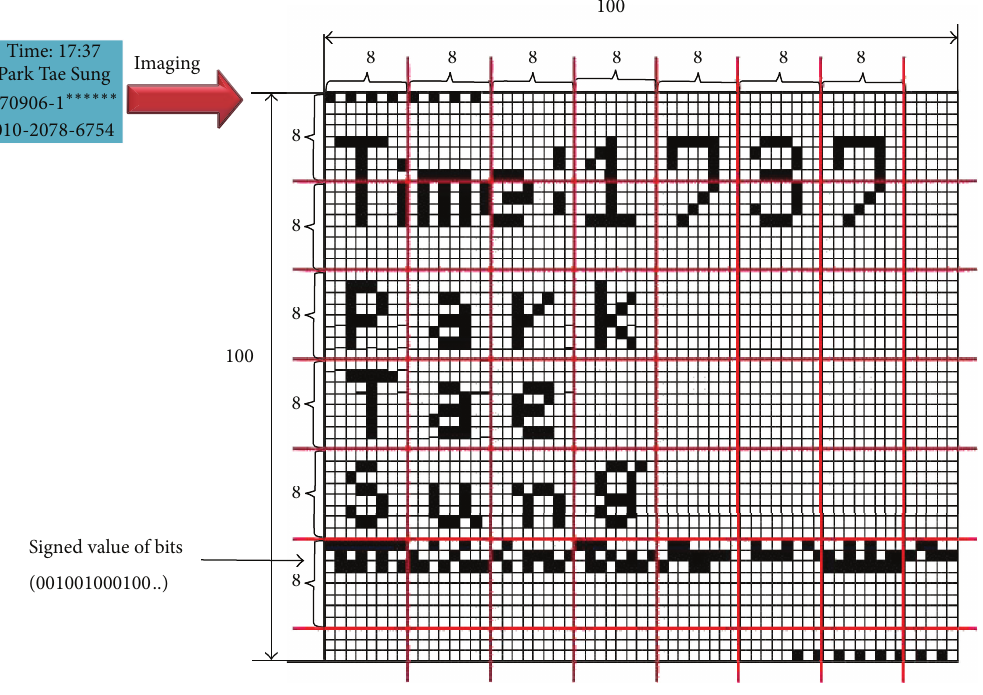
Figure 4: After shift of steganography-inserted data.